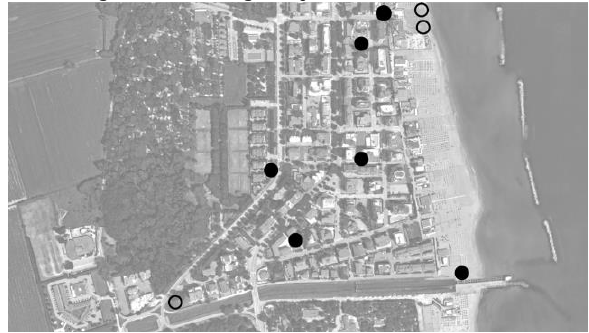
Figure 5. Lido di Savio (RA), Map of the existing and destroyed bunkers. © Mariotti, Zampini,